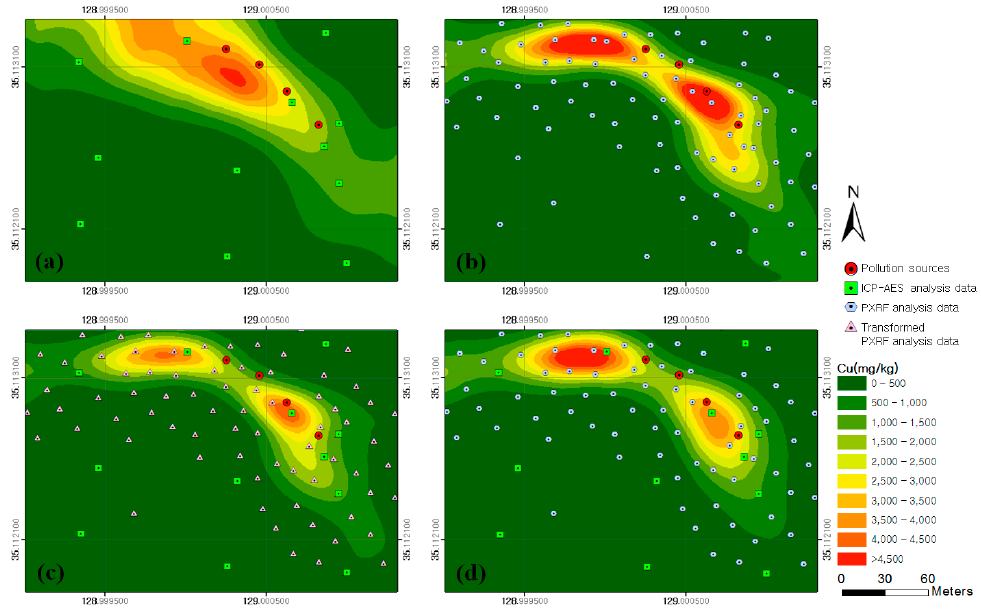
Figure 6. Soil contamination maps for copper generated by approaches: ( a ) 1; ( b ) 2; ( c ) 3; and ( d ) 4.